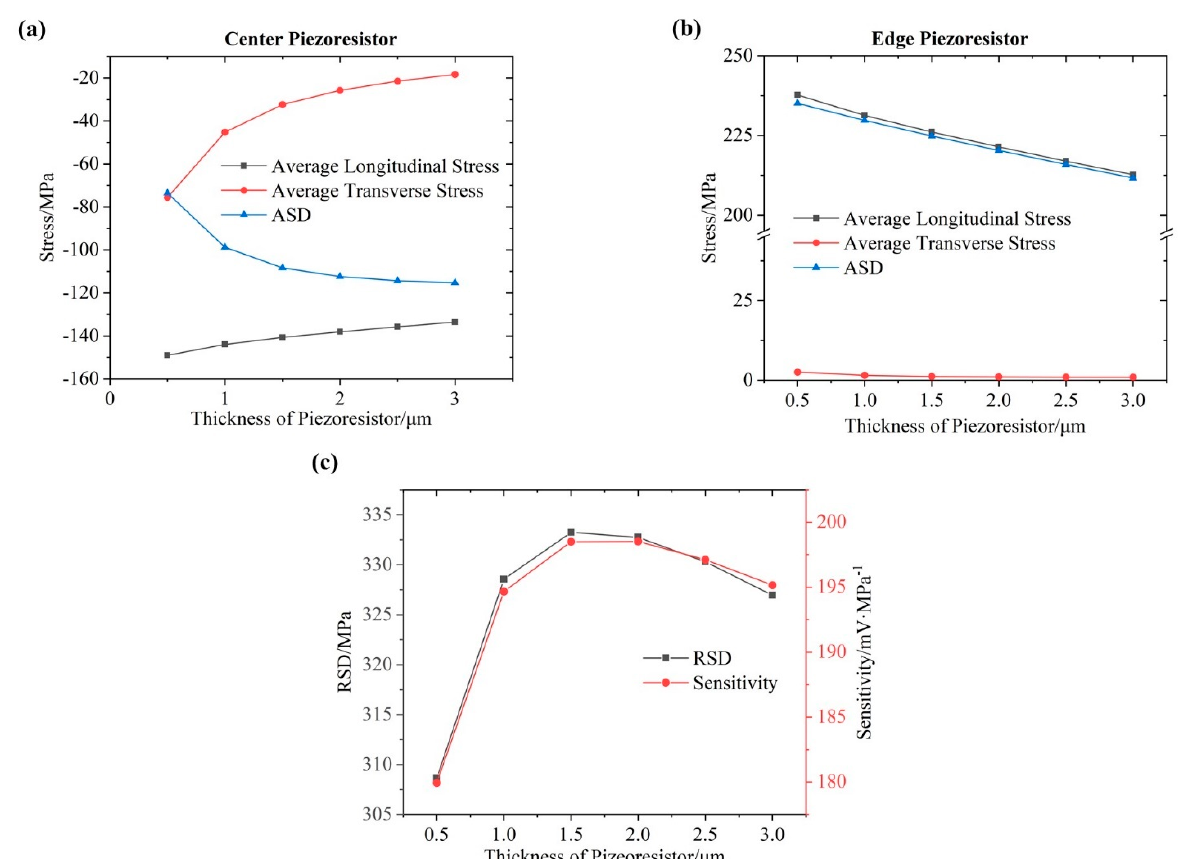
Figure 5. ( a ) The average longitudinal/transverse stresses and ASD of the center piezoresistor as a function of the thickness; ( b ) the average longitudinal/transverse stresses and ASD of the edge piezoresistor as a function of the thickness; ( c ) the RSD between the center piezoresistor and the edge piezoresistor and the sensitivity of the developed sensor as a function of the thickness.